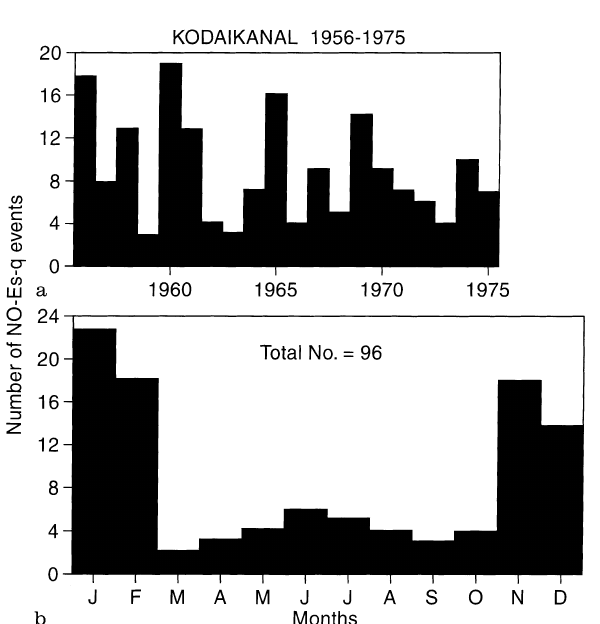
Fig. 2. a Year to year variations of No - E s - q events at Kodaikanal during the interval of 1000–1200 LT; 2 b month to month variation of the total number of No - E s - q events at Kodaikanal averaged for the period of